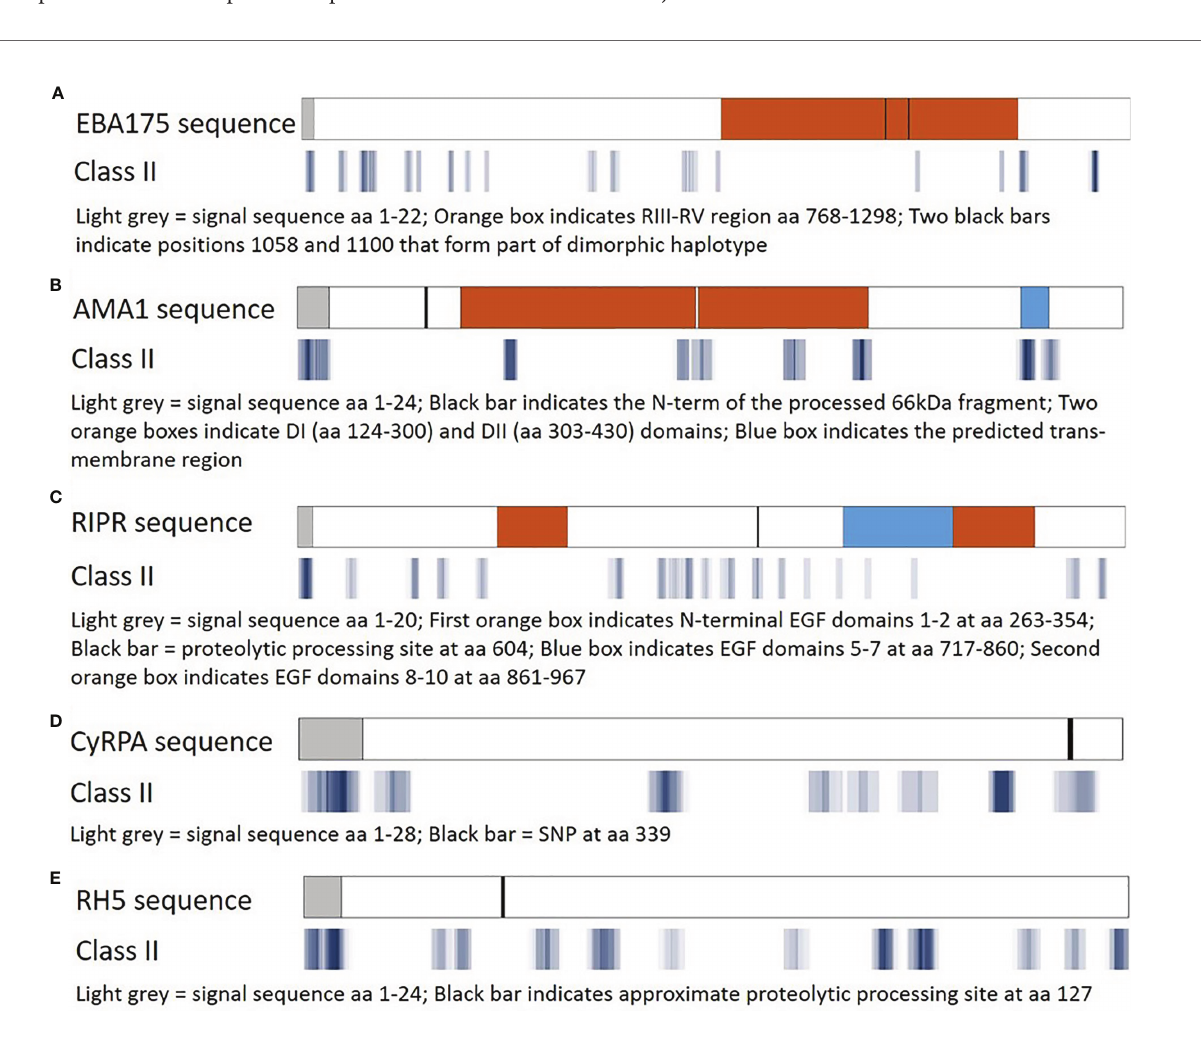
FIGURE 3 | Predicted class II epitope coverage for Pf blood stage proteins. Major regions and features of EBA175 (A) , AMA1 (B) , RIPR (C) , CyRPA (D) , and RH5 (E) are shown in the top bar for each panel and aligned with predicted class II epitope clusters in the bottom bar for each panel. The predicted epitope binding frames are shown in blue with darker hues denoting a higher number of EpiMatrix hits (9-mer sequences with an EpiMatrix Z-score >1.64), lighter hues denoting fewer hits, and white spaces denoting no